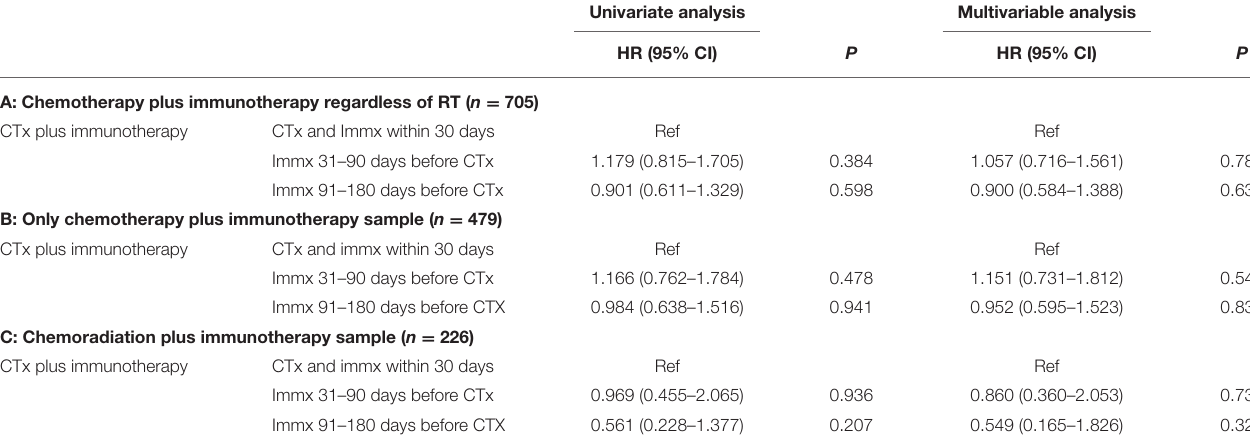
TABLE 3 | Univariable and multivariable cox regression analysis of the sequence of chemotherapy and immunotherapy. Univariate analysis Multivariable analysis